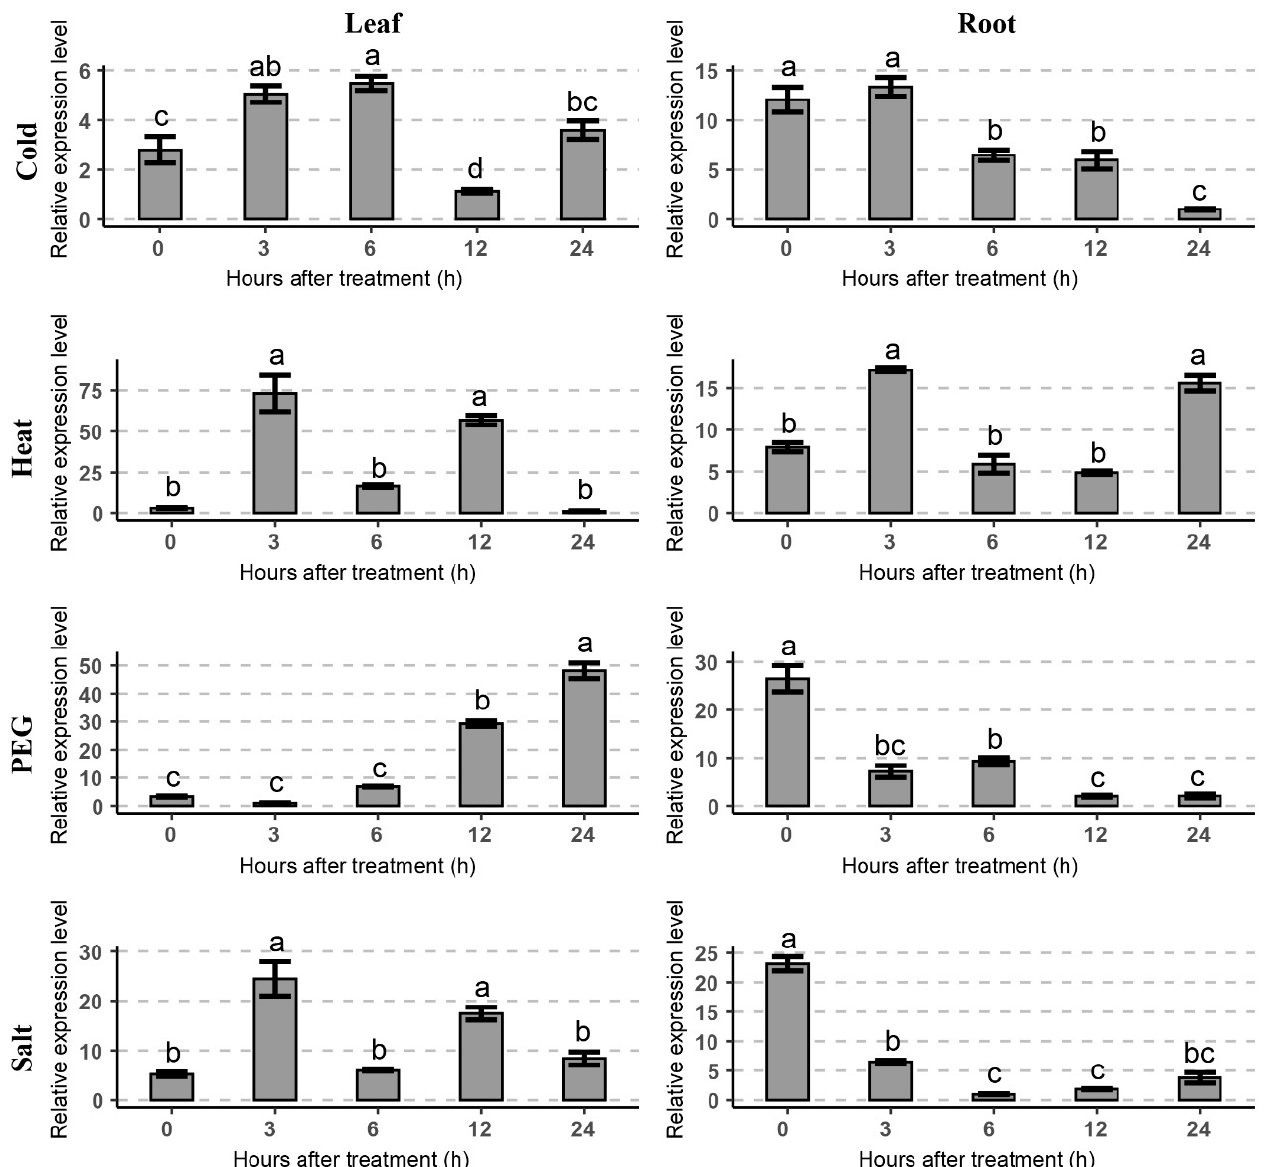
Figure 4. Expression patterns of GhTIP1;1-like in various tissues of 28-day-old cotton seedlings under different stress treatments. Expression levels of GhTIP1;1-like were determined from cotton leaf, and root under cold (4 ◦ C), heat (42 ◦ C), salt (300 mM NaCl), and dehydration (10% PEG6000) stresses using RT-qPCR analysis. Significant difference at p < 0.05 is indicated by different letters above the columns (Tukey’s test).